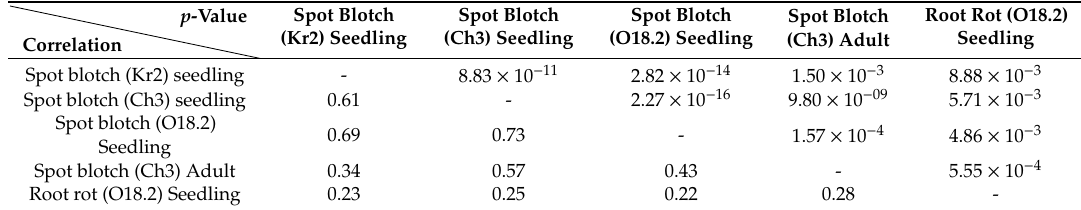
Table 1. Pearson correlation analysis between resistance to spot blotch and common root rot, as well as between resistance to spot blotch between seedlings and adult